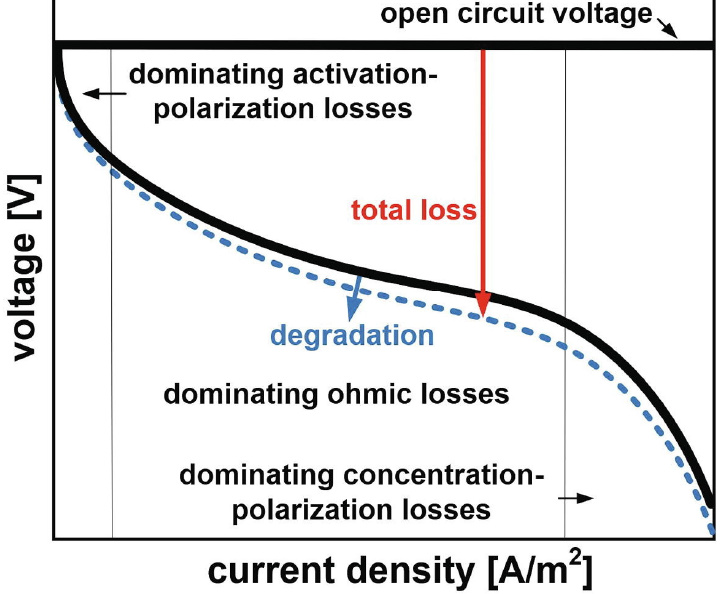
Figure 10. Principal current density-voltage relationship for a SOFC, including deactivation. Reprinted with permission from ref. [43]. Copyright 2021,